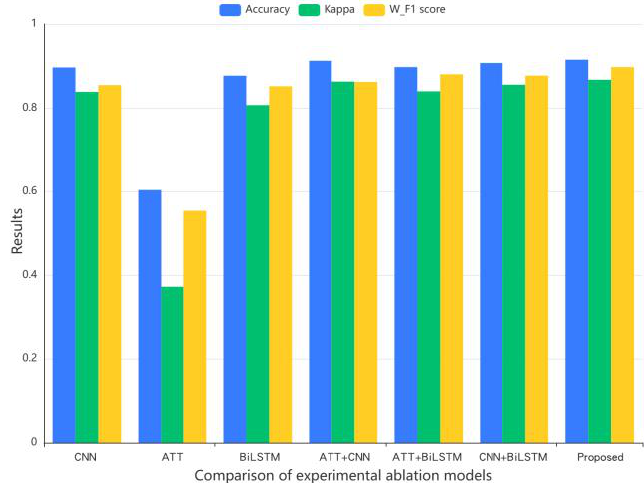
Figure 12. Comparison of experimental ablation models.